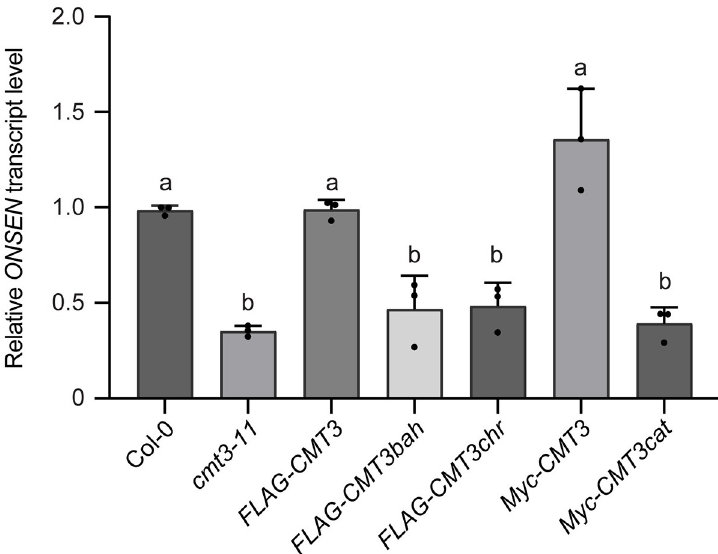
Fig 2. BAH, chromo, and catalytic domains of CMT3 are required for heat-induced ONSEN transcription. Bar graph showing relative ONSEN transcript level under heat stress in Col-0, cmt3-11 , and transgenic plants expressing wild-type CMT3 ( FLAG-CMT3 ), BAH domain mutant ( FLAG-CMT3bah ), chromo domain mutant ( FLAG-CMT3chr ), wild-type CMT3 ( Myc-CMT3 ), and catalytic domain mutant ( Myc-CMT3cat ) in cmt3-11 background. The relative transcripts were first normalized to ACT7 , and then Col-0. All bars represent mean + SD from three biological replicates. Different letters represent significant differences (P < 0.05 by Student’s t -test) between